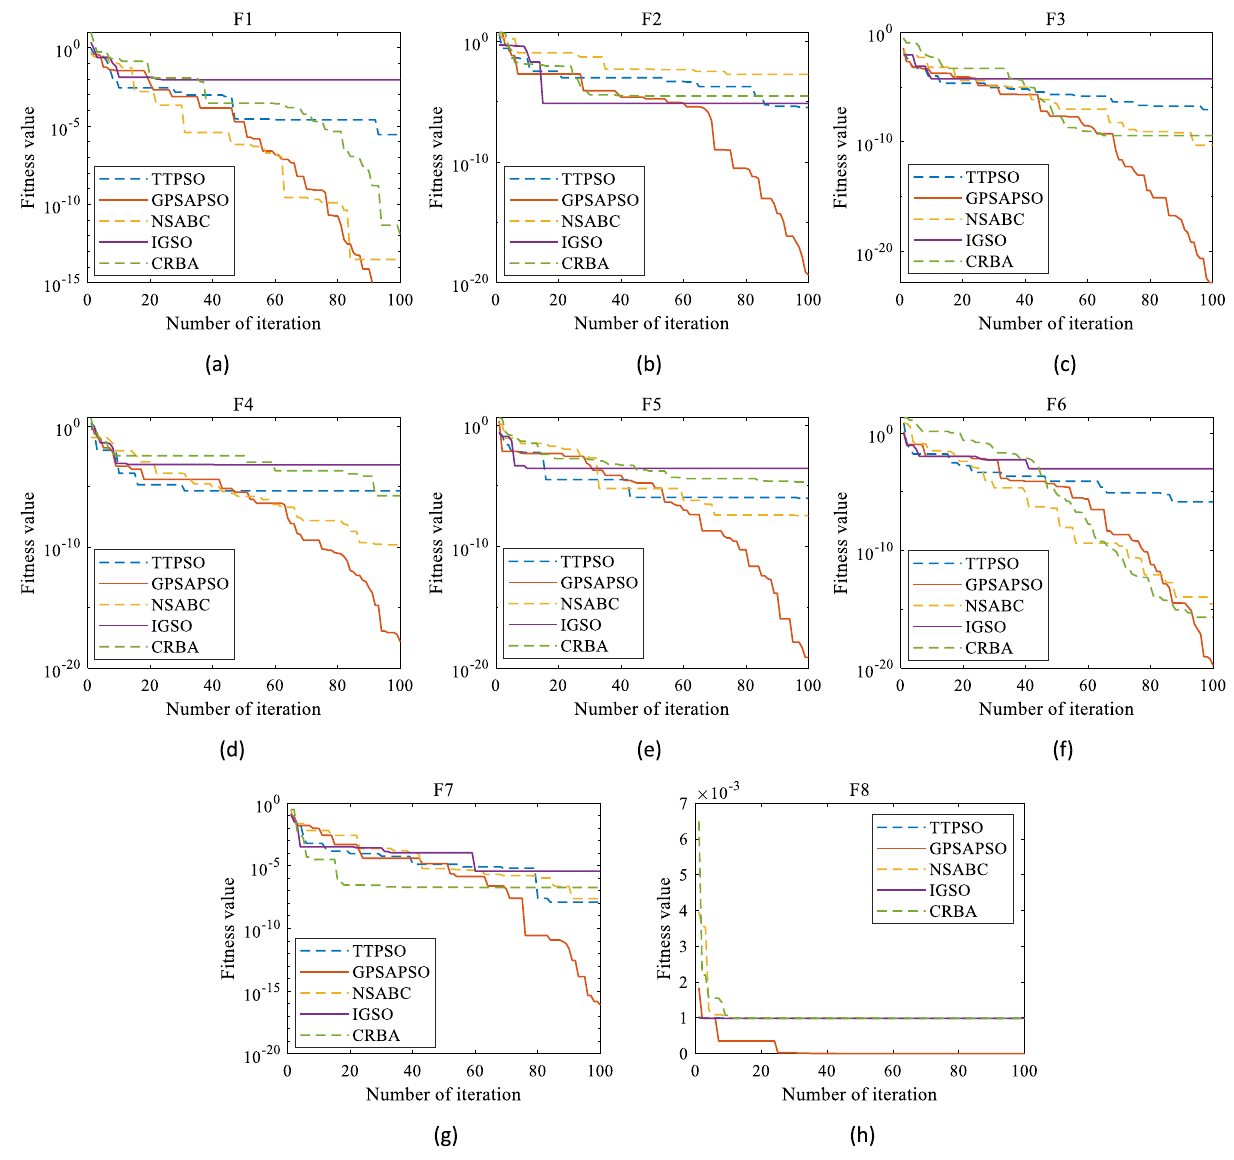
Figure 5. Iterative process of low dimensional